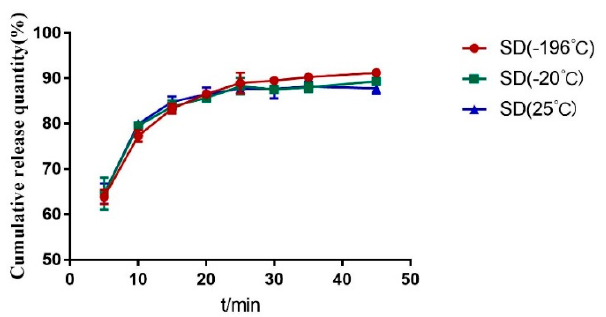
Figure 5. DSC diagram of solid dispersion prepared by different cooling temperature.